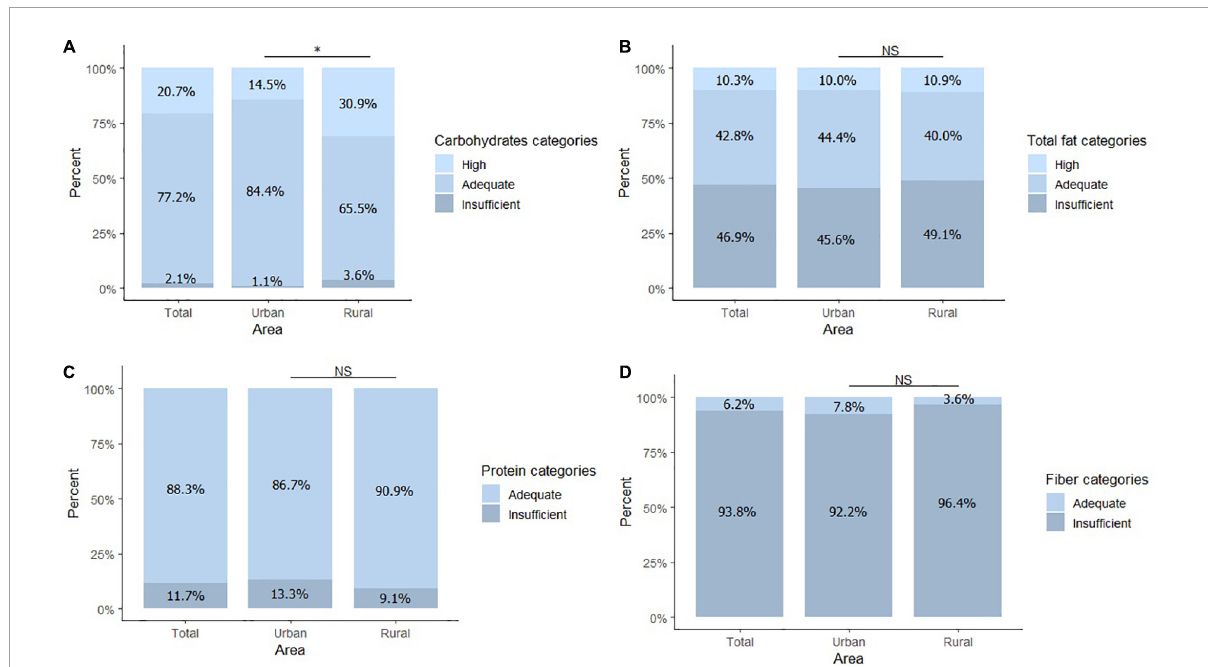
FIGURE3 Dietary intake according to recommendation. (A) Percentage of children within high, adequate, and insufficient carbohydrate consumption category. (B) Percentage of children within the high, adequate, and insufficient total fat consumption category. (C) Percentage of children within the adequate and insufficient protein consumption category. (D) Percentage of children within the adequate and insufficient fiber consumption category. Total n = 145, Urban n = 90, Rural n = 55. The difference in sample size among the study variables is explained by the fact that not all parents in the rural area were able to schedule a meeting for the 24-recall. ∗ P < 0.05. NS, no significant